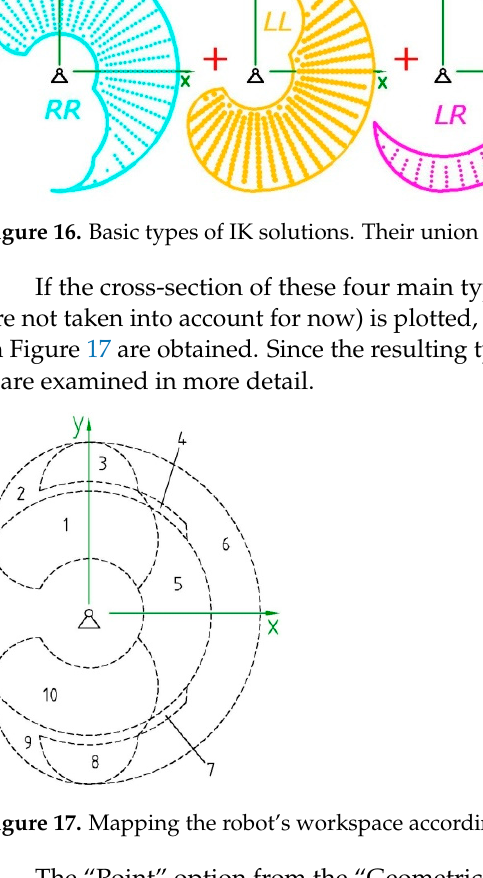
Figure 18. Result of applying the algorithm for point P, located in areas 1 to 6, according to Figure 17. Region 1—only RR type configurations are possible (illustrated in Figure 18). These solutions fall into the first and second octants of the configuration space. In the symmetric